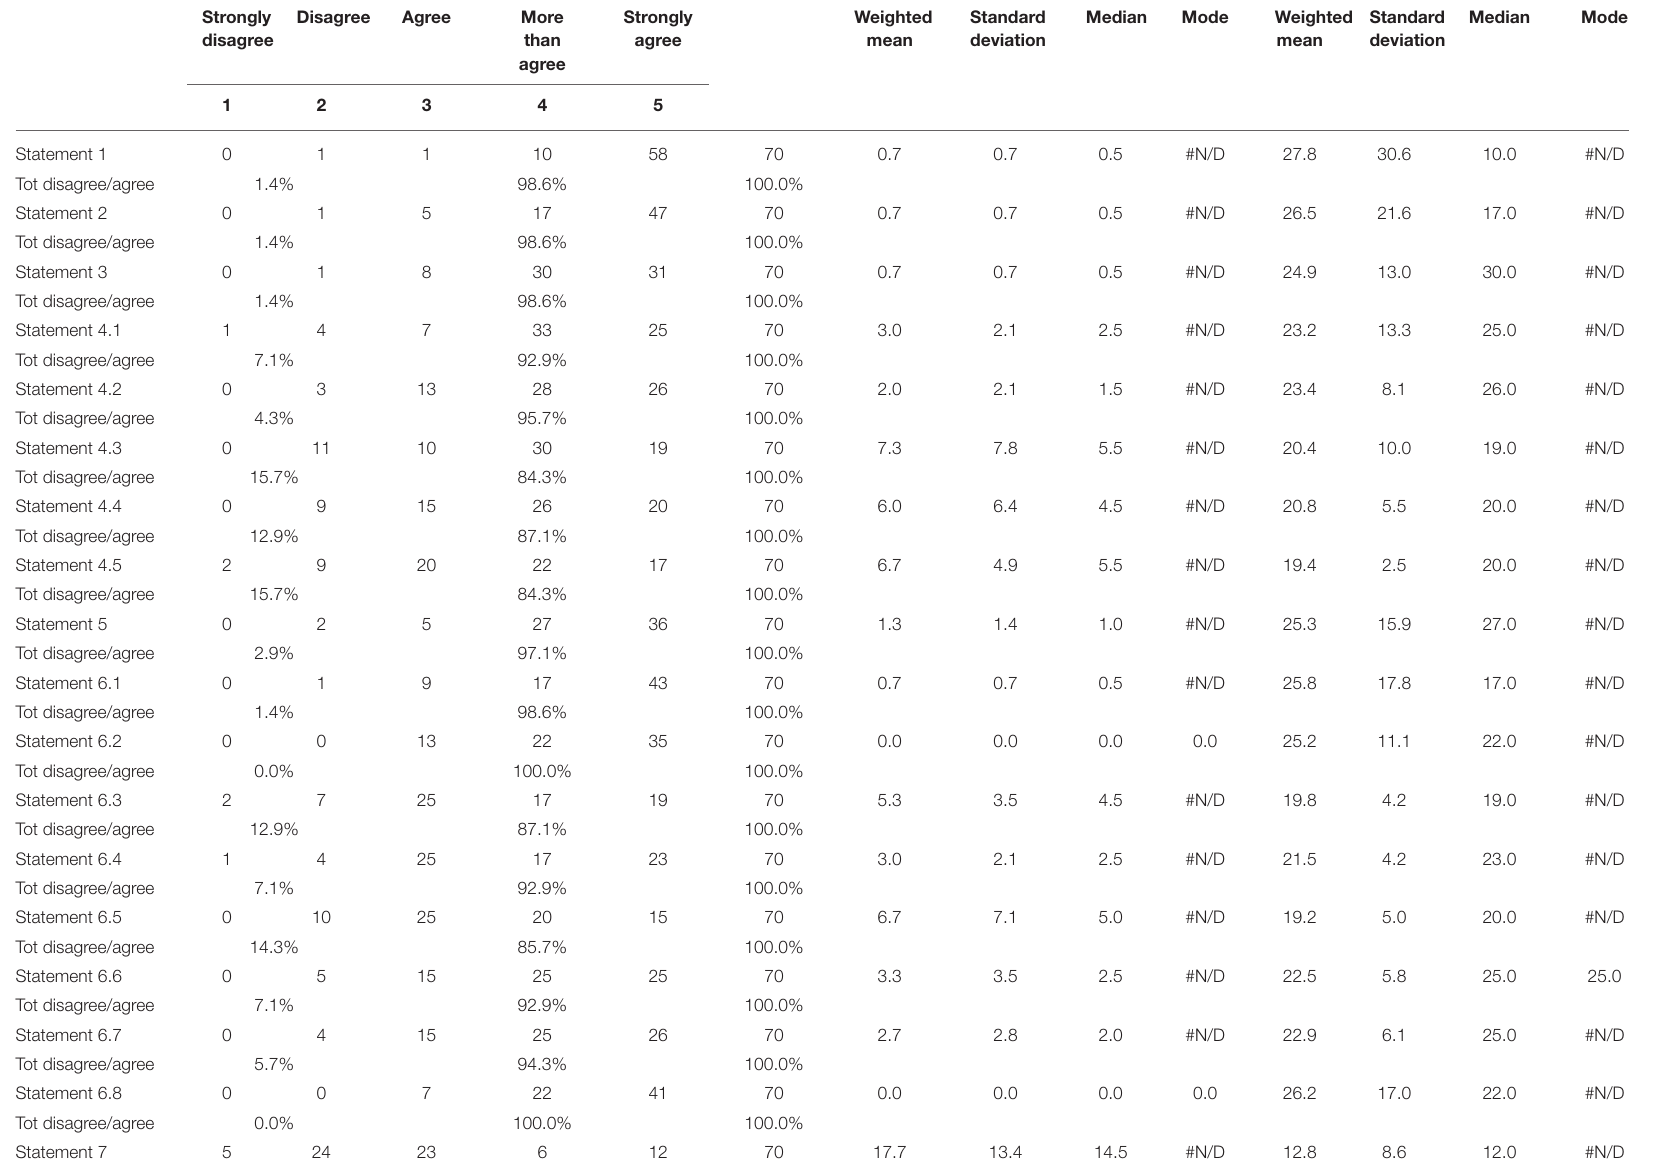
TABLE 2.2 | Mean, median, mode and standard deviation of the consensus statement.